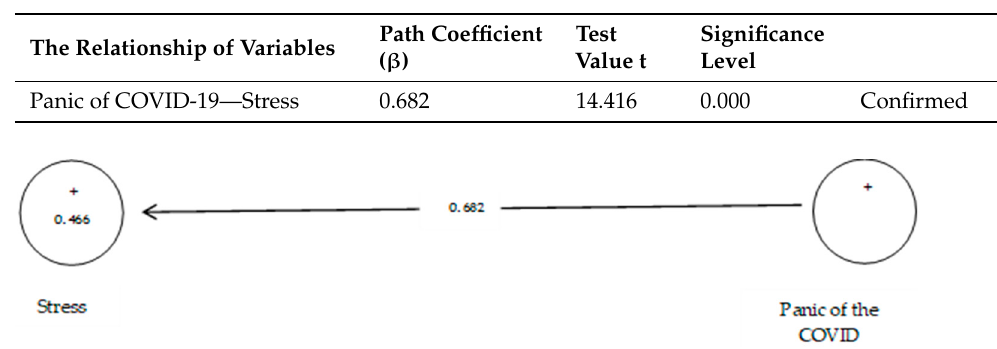
Table 14. Evaluation indicators of the internal model of the research, direction and significance of direct effects.